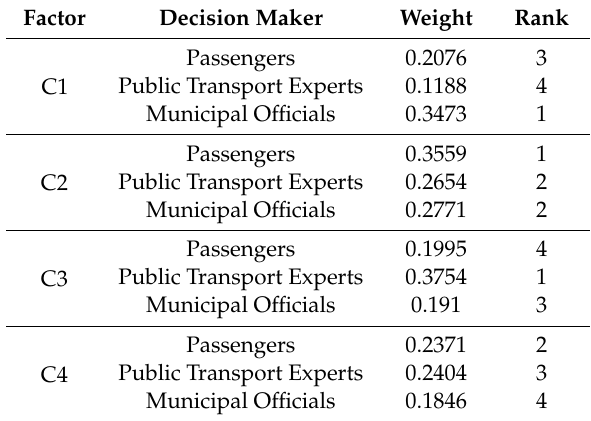
Table 7. The final weights and level ranks for the factors in the first level. Factor Decision Maker Weight Rank C1